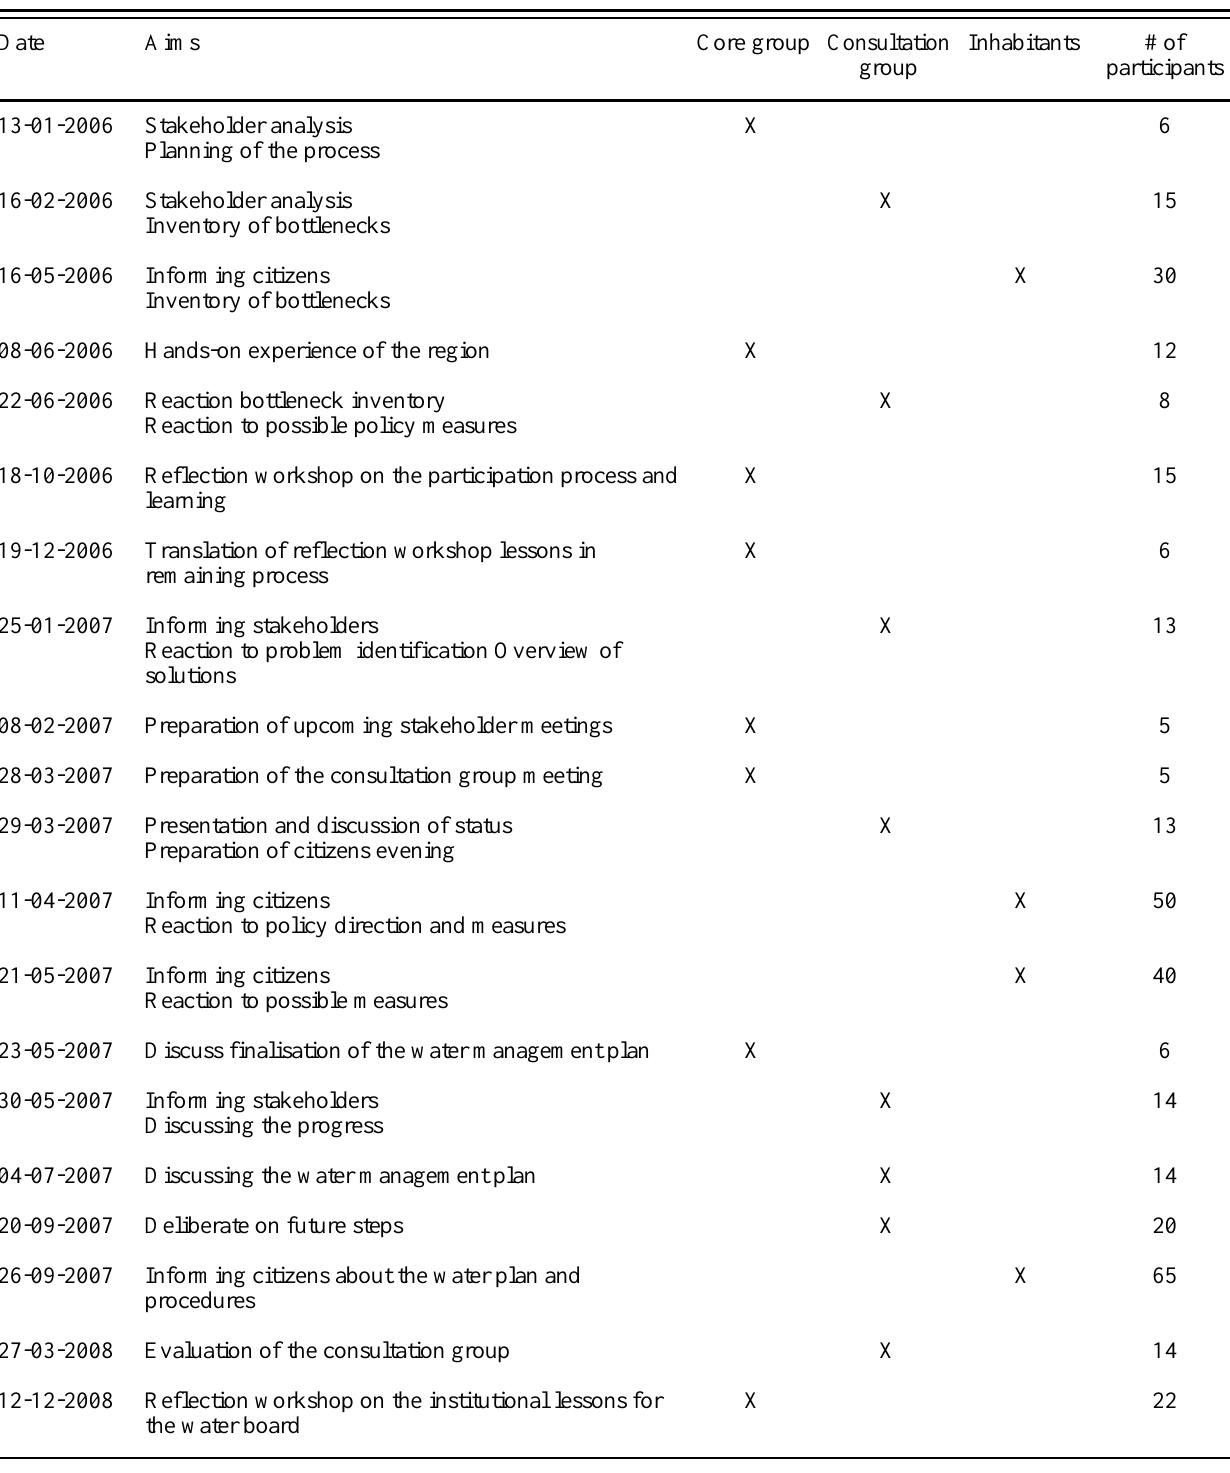
Table 4. Overview of events in the Kromme Rijn participation